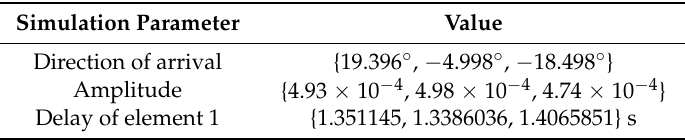
Table 4. Simulation parameters target at − 5 ◦